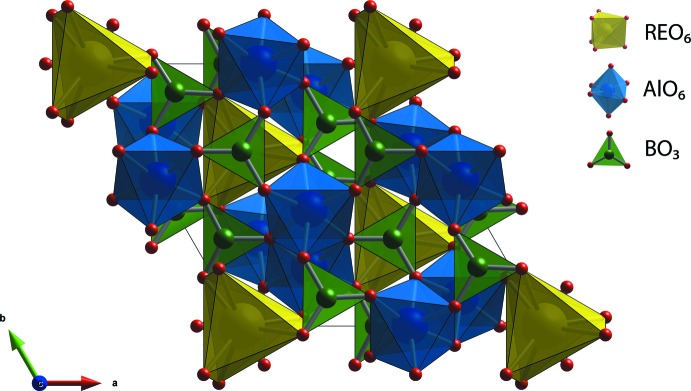
Crystal structure of REAl3(BO3)4.